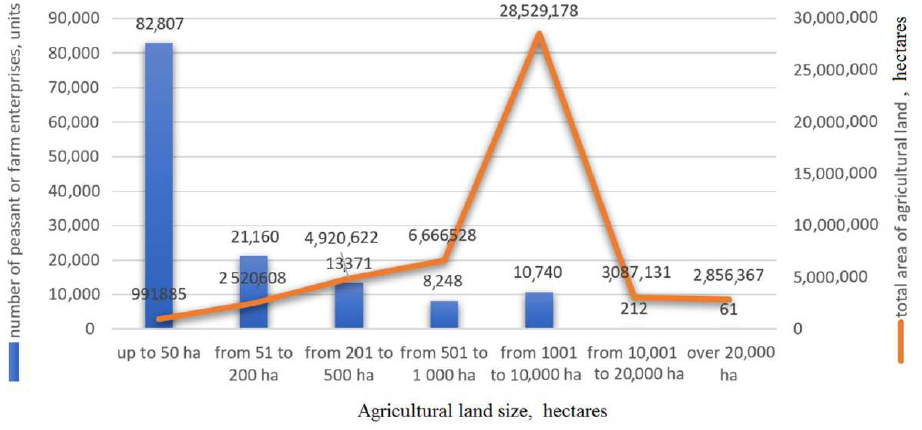
Figure 3. The number of peasant or farm enterprises and the total area of agricultural land possessed in 2019